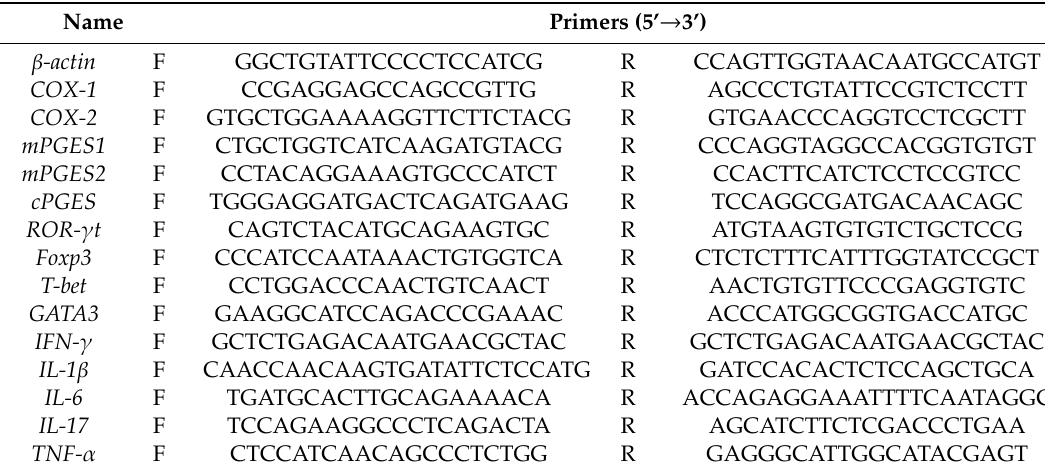
Table 1. The primer sequences of